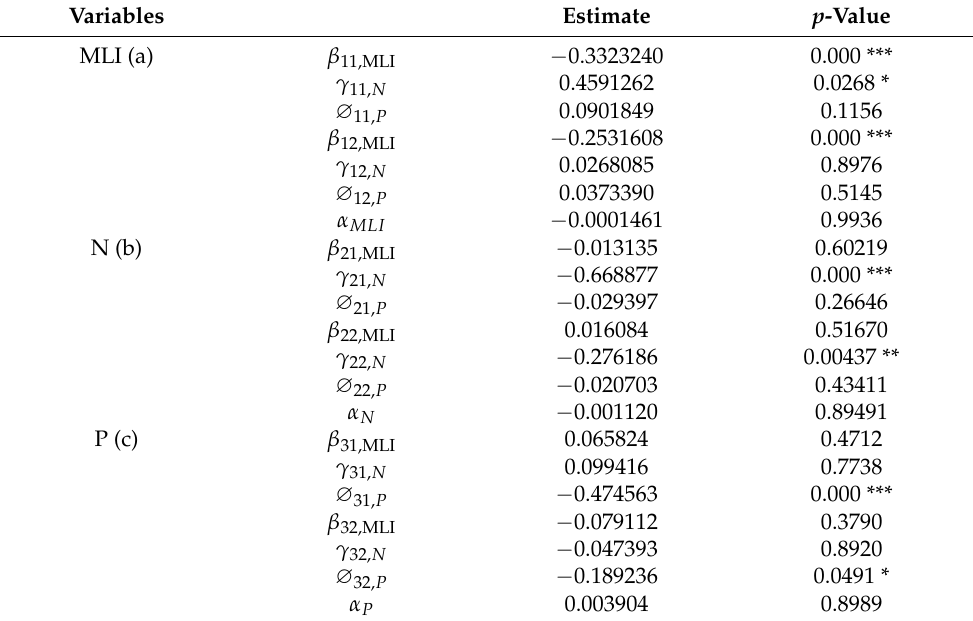
Table 4. Estimation of VAR coefficients and significance test values, MLI model.